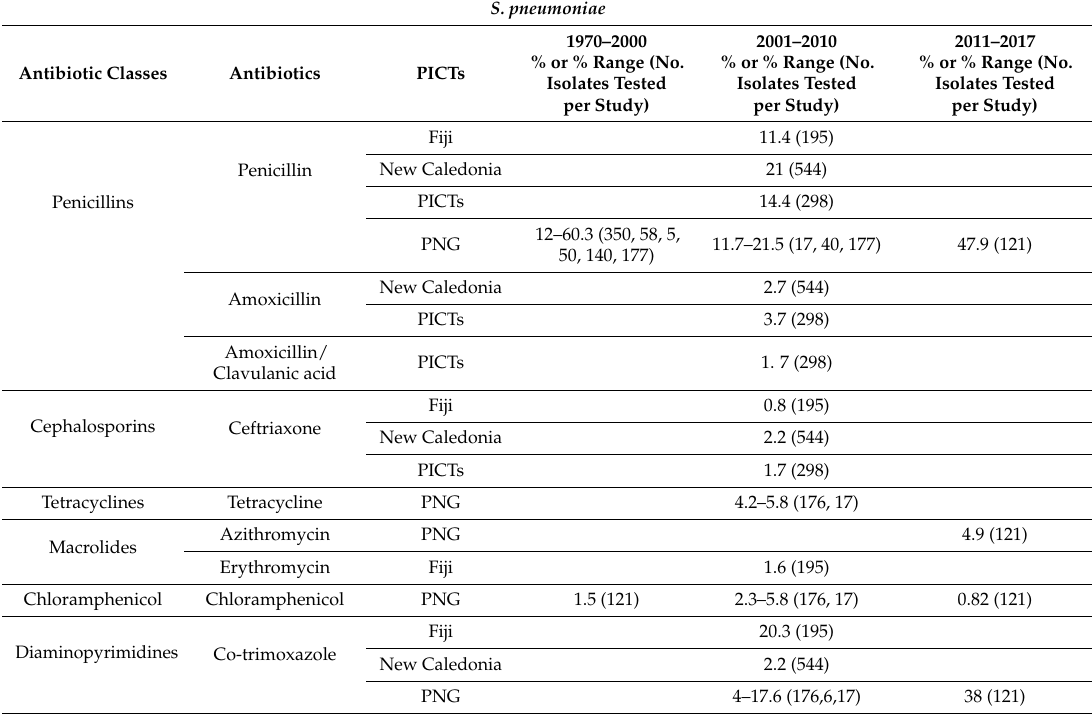
Table 5. Prevalence of ABR in Streptococcus pneumoniae in PICTs reported by country and